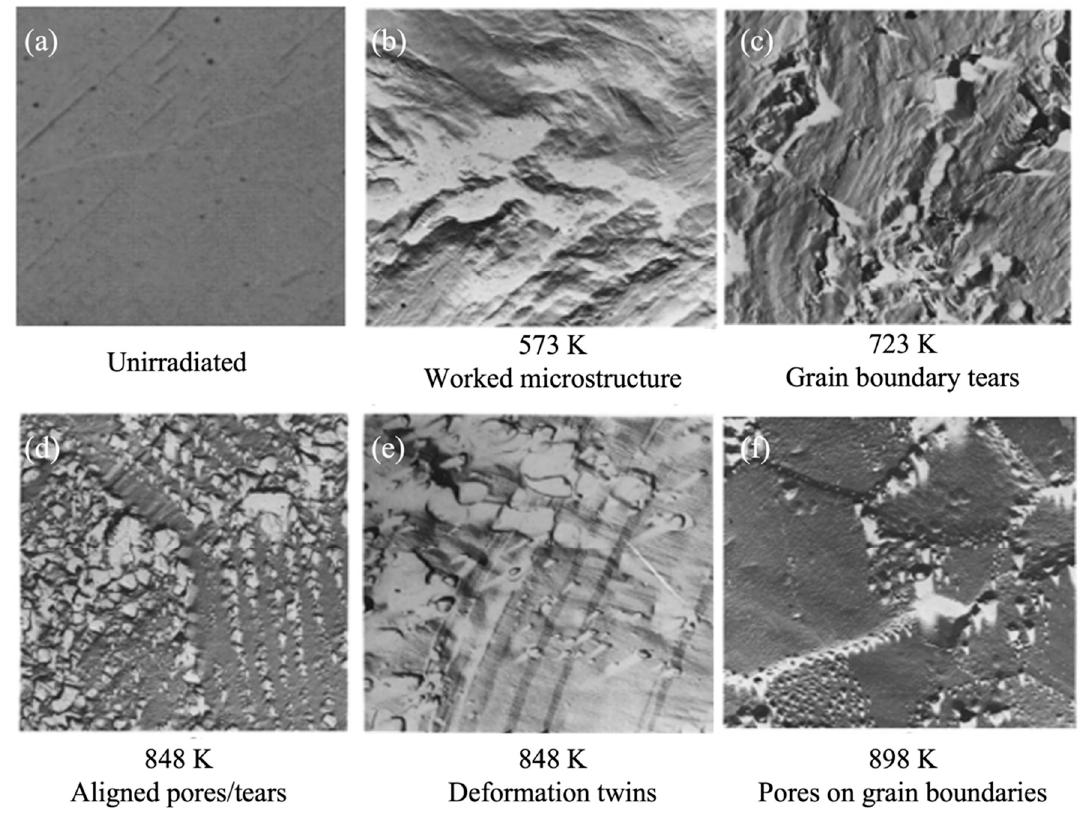
Figure 7. Scanning electron microscopy images of irradiated α -U showing the microstructure evolution at different irradiation temperatures [46].